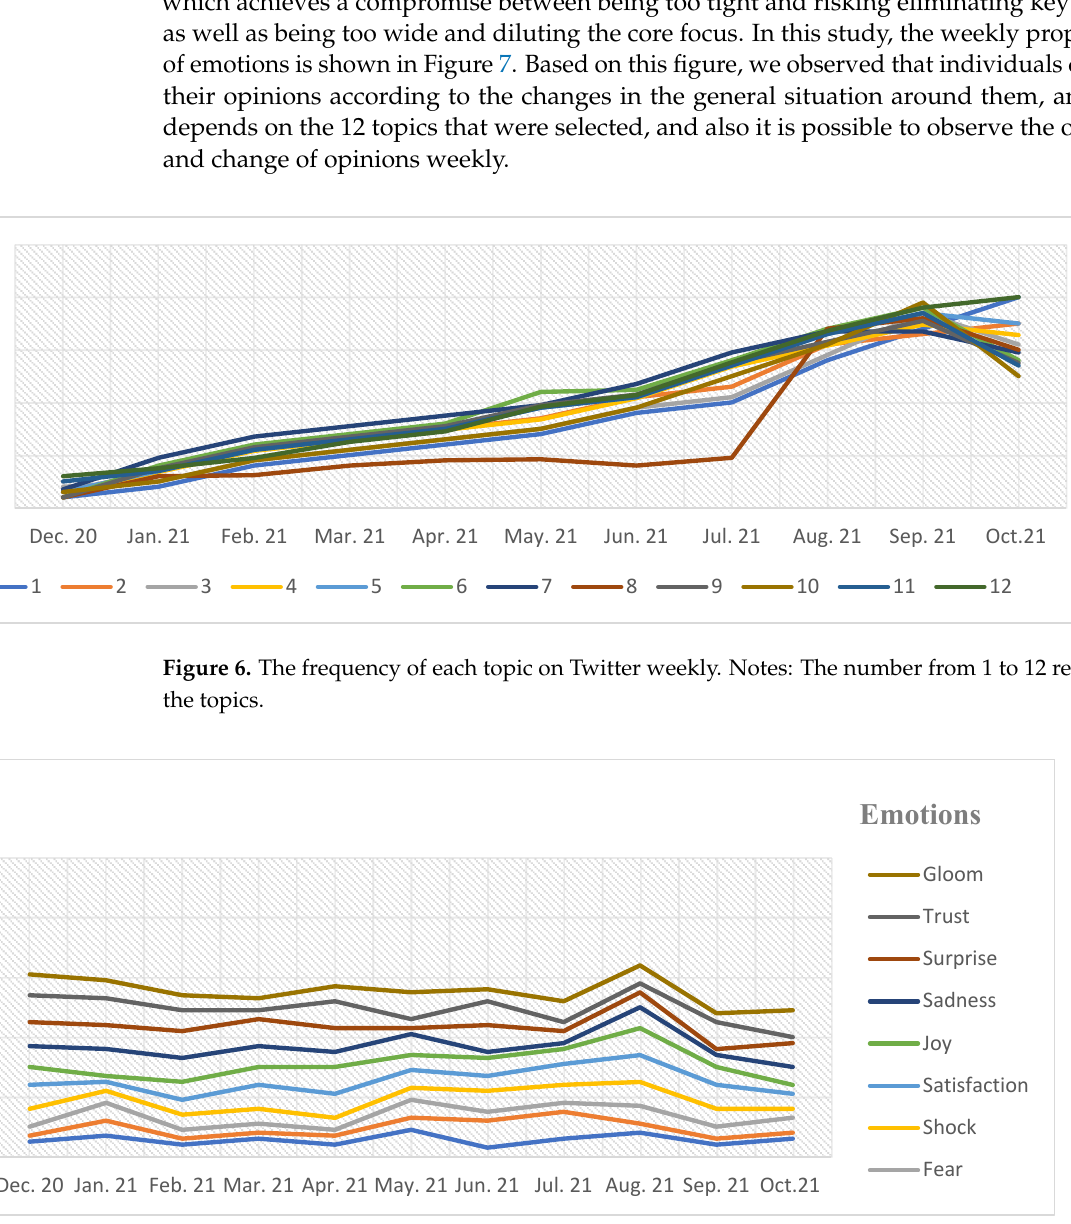
Figure 7. The weekly changes of emotional terms are based on 12 topics.